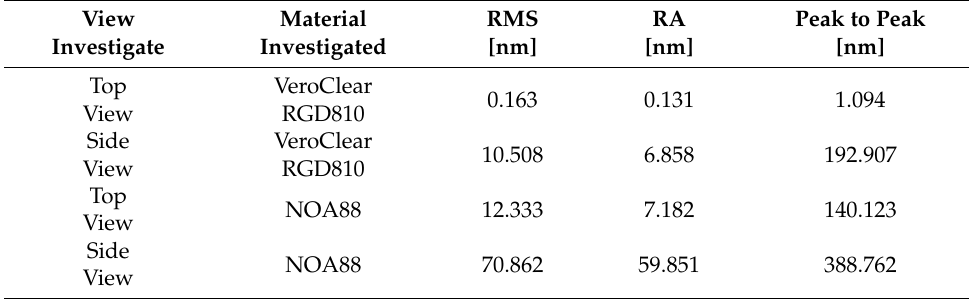
Table 1. AFM analysis results.